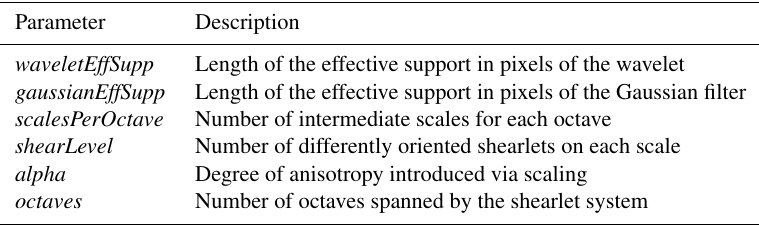
Table 1. Shearlet system parameters.